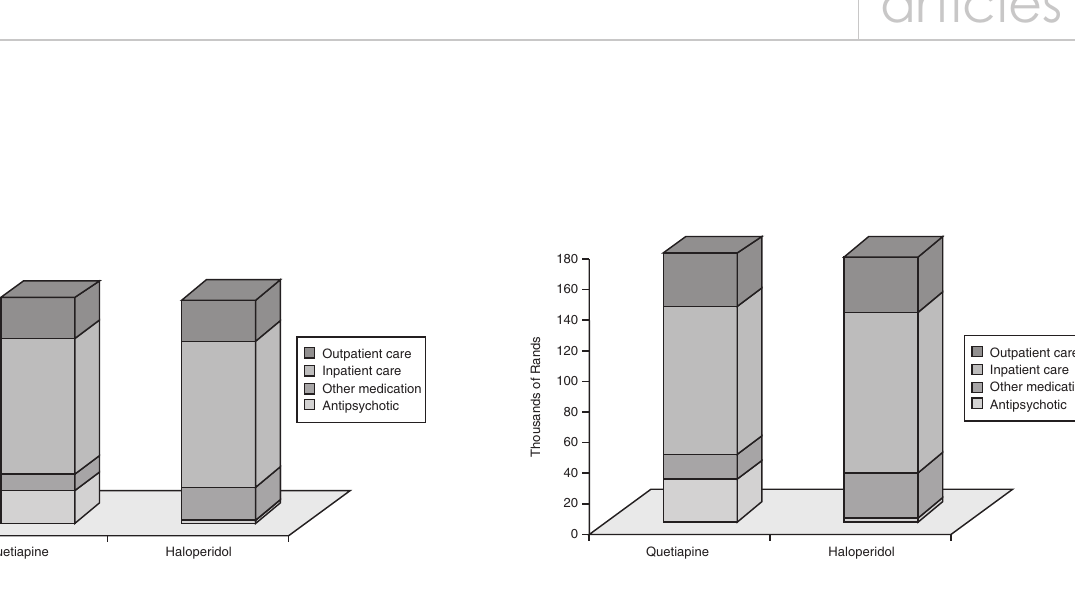
Fig. 1. Total estimated direct costs per patient treated in the private sector in South Africa.